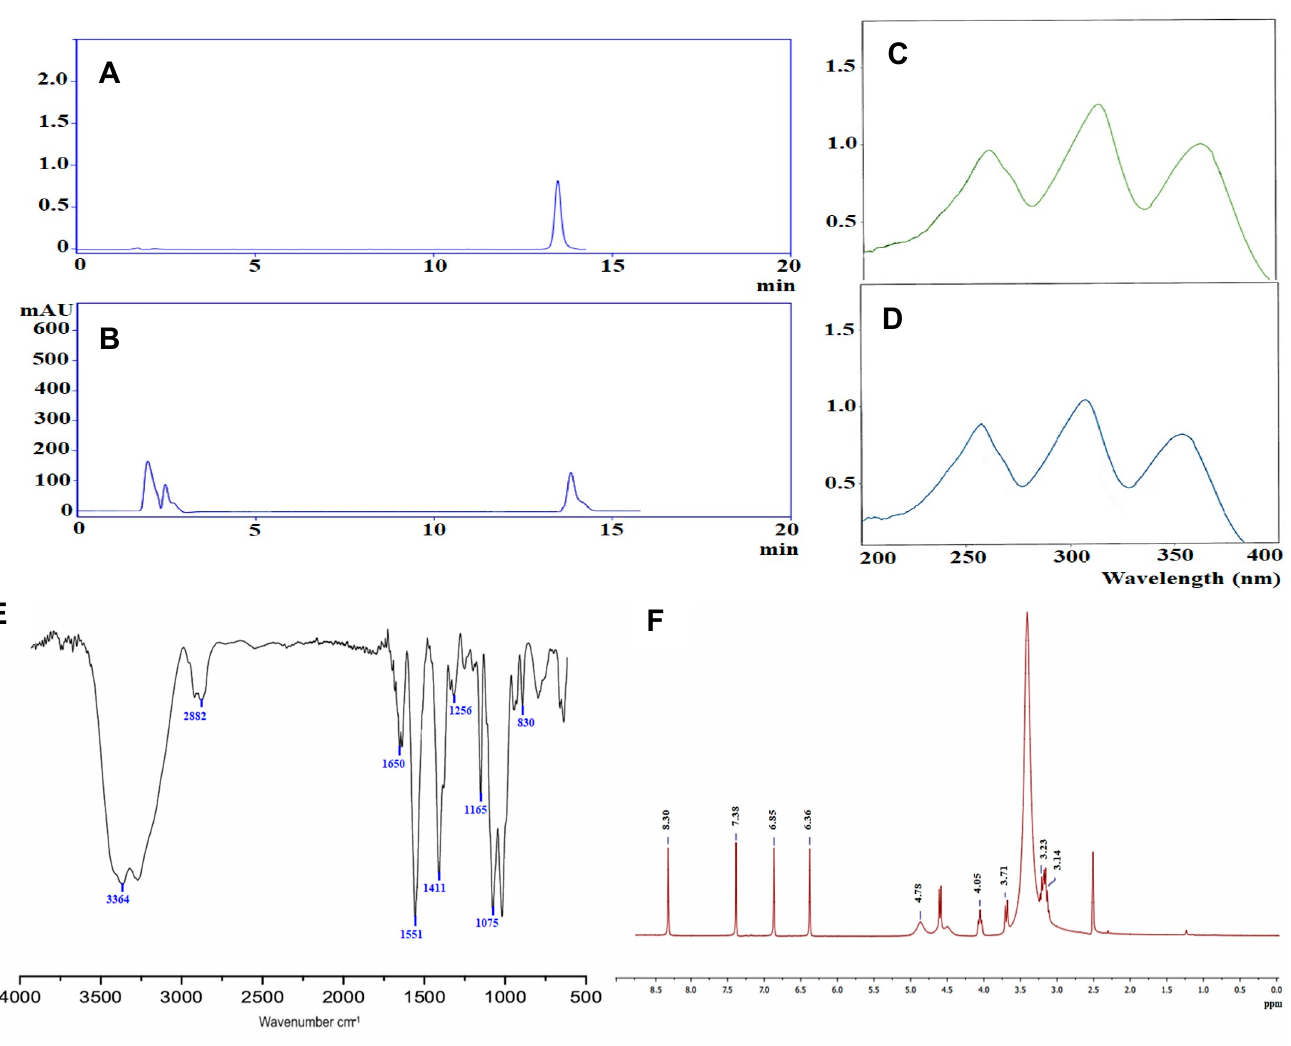
Figure 1. Structural elucidation of mangiferin isolated from M. indica . ( A ) HPLC pattern of standard mangiferin, ( B ) purified mangiferin. ( C ) UV–vis spectrum of standard, ( D ) mangiferin. ( E ) Mangiferin’s FTIR spectral analysis (4000–500 cm − 1 ). ( F ) 1 H NMR chemical shift (ppm) values in DMSO (400 MHz).